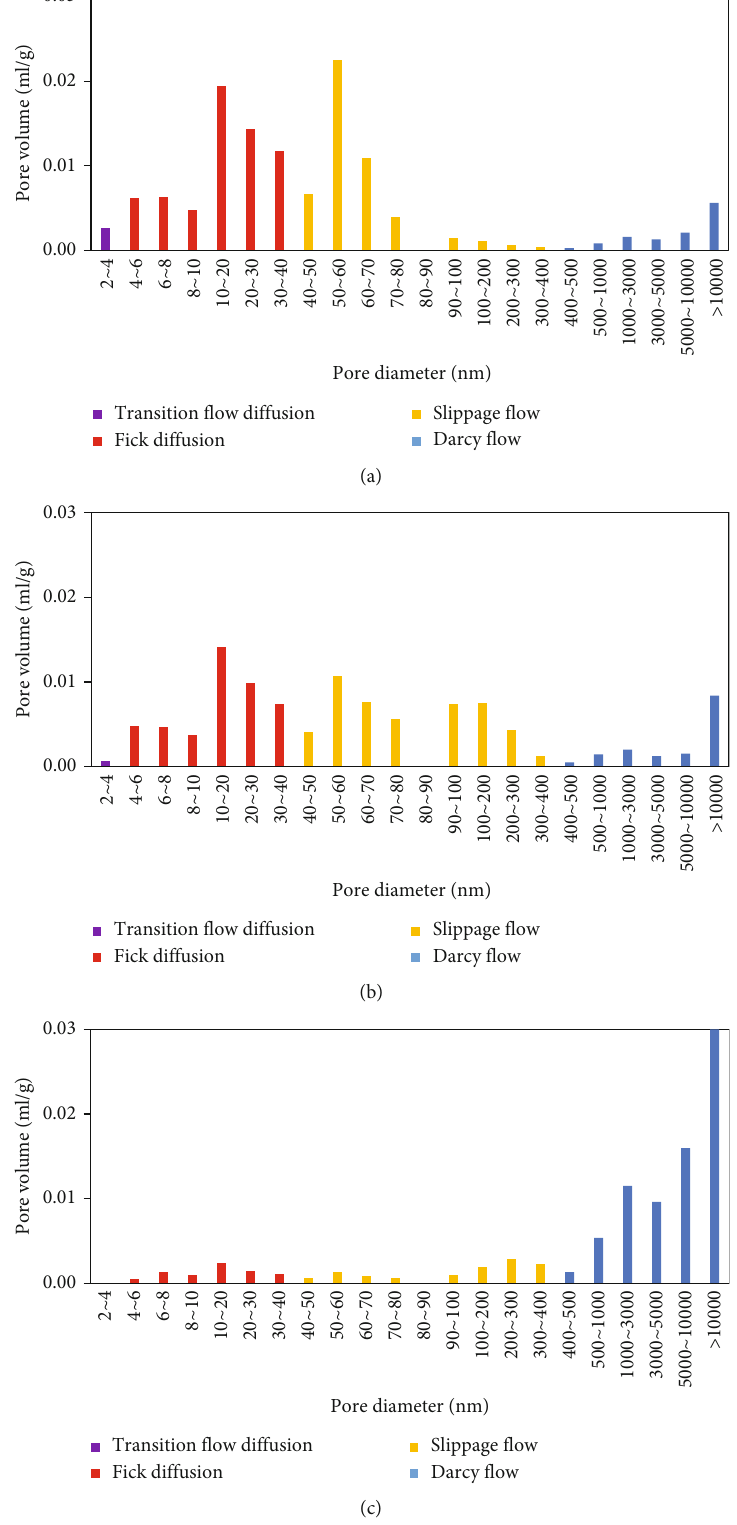
Figure 15: Gas migration form of di ff erent pores in Qigequan Formation mudstones. (a) H-3: pure mudstone, Fick di ff usion, and slippage fl ow; (b) H-6: silty mudstone, Fick di ff usion, slippage fl ow, and Darcy fl ow; (c) H-7: sandy mudstone and Darcy fl